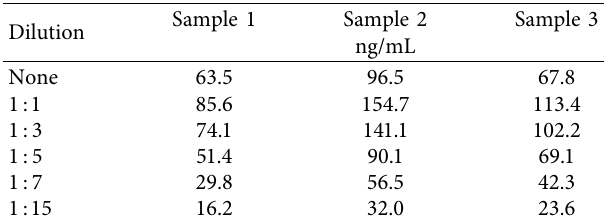
Table 1: Osteocalcin concentrations in serum samples after several